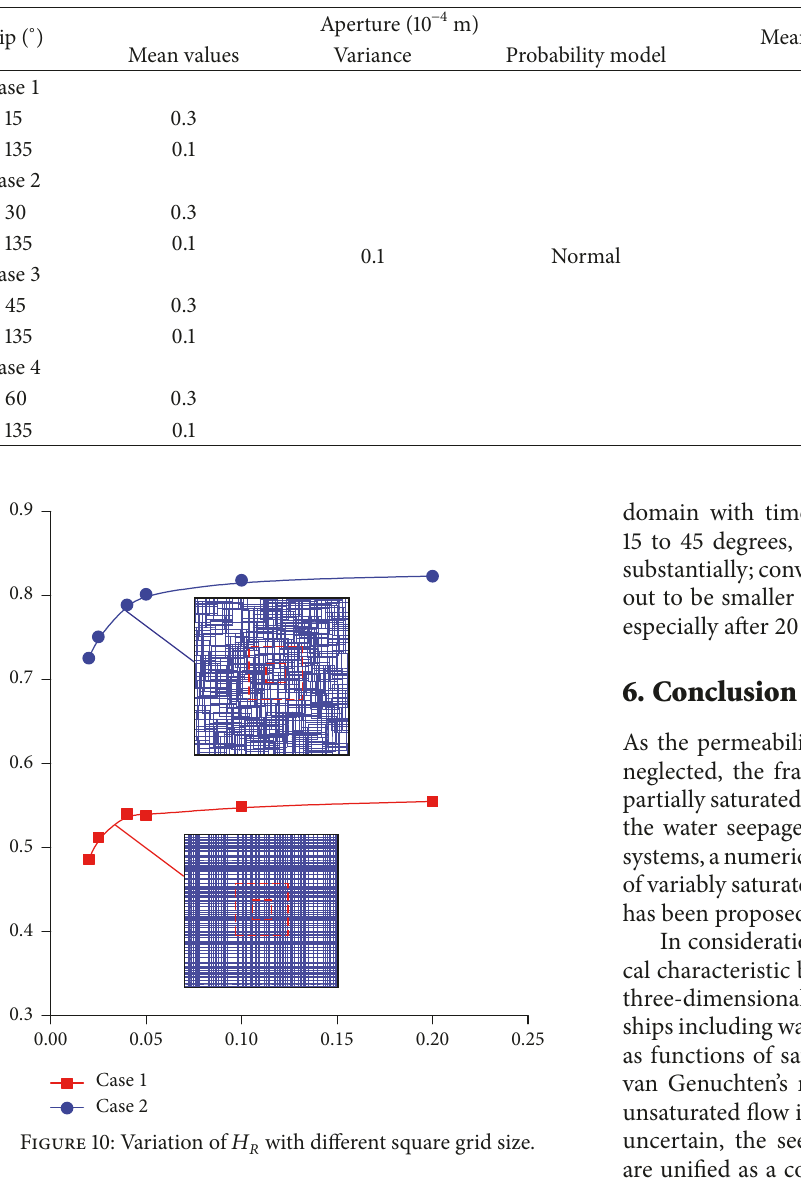
Table 3: Parameters of fractures and probability model.